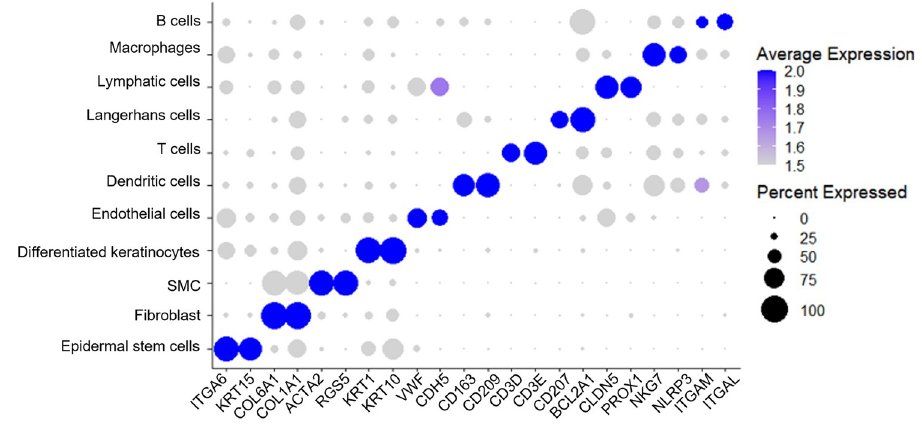
Fig 5. Dot plot of marker genes for pig skin